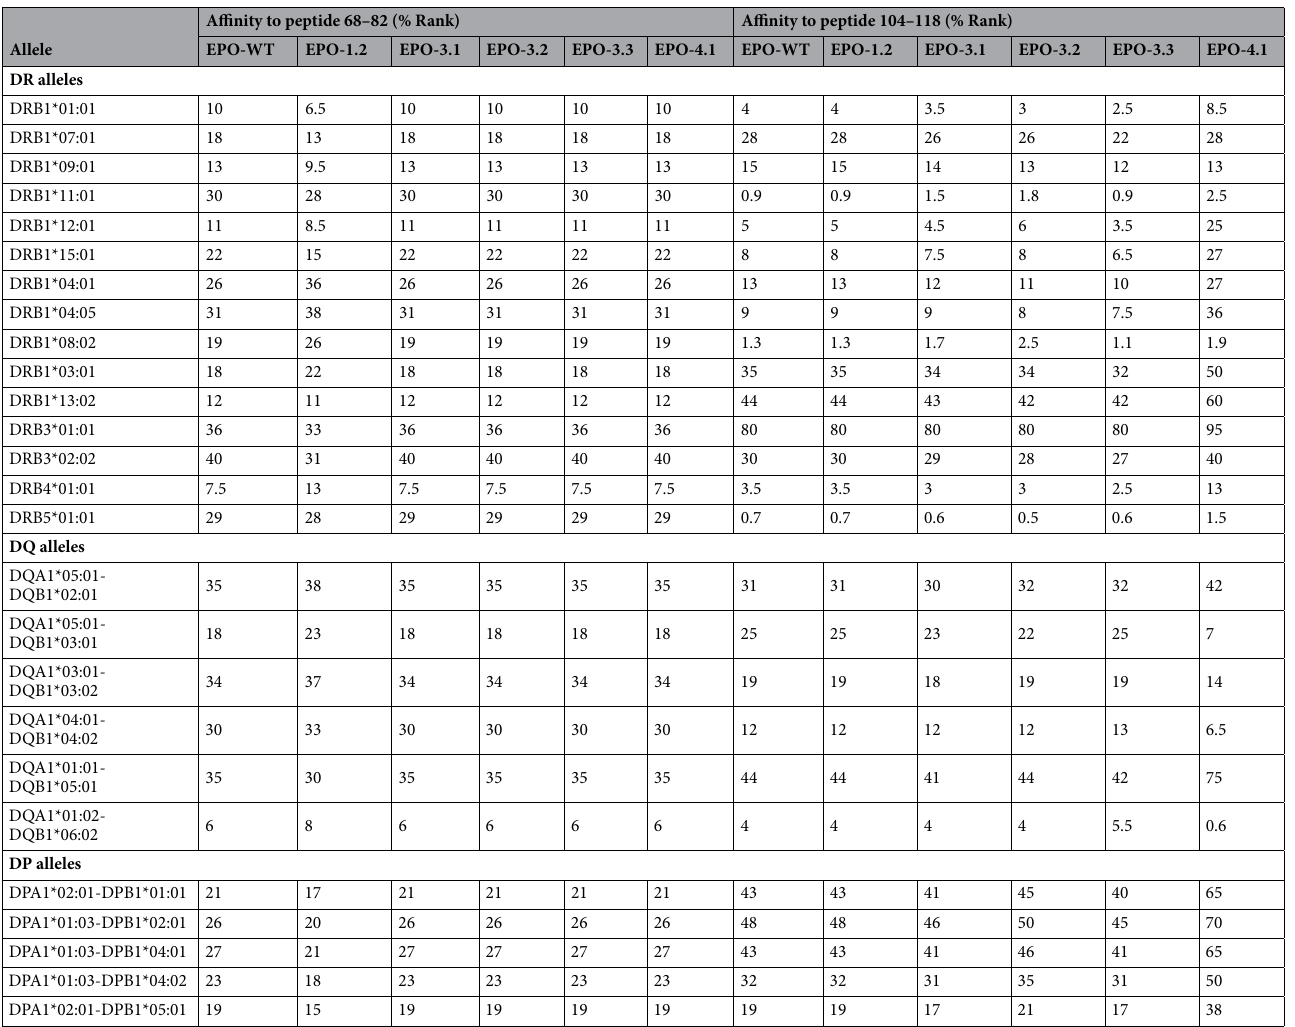
Table 3. Predicted binding between EPO variants and common HLA class II